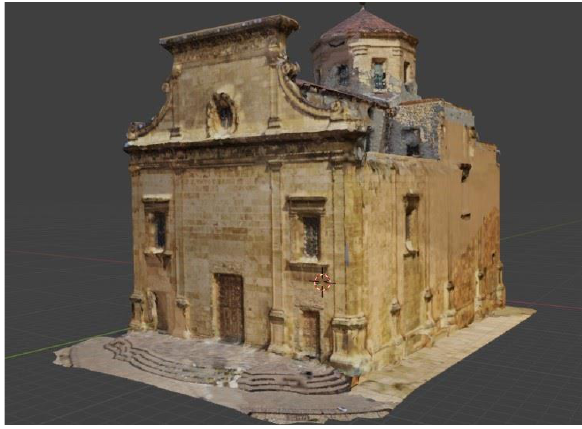
Figure 7. The textured mesh model of the church obtained following the first solution after editing operations in